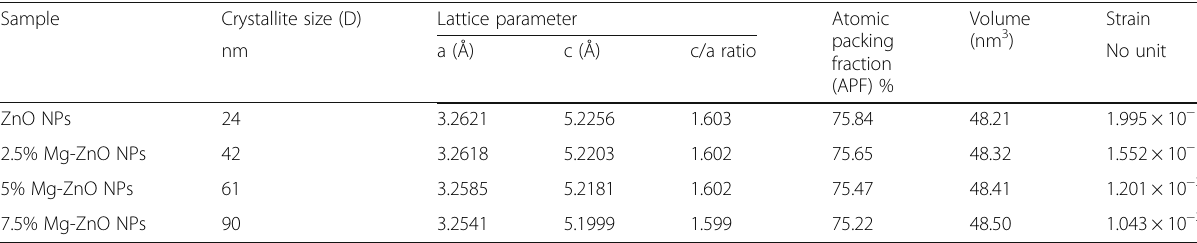
Table 1 Lattice parameters of pure and Mg-ZnO NPs